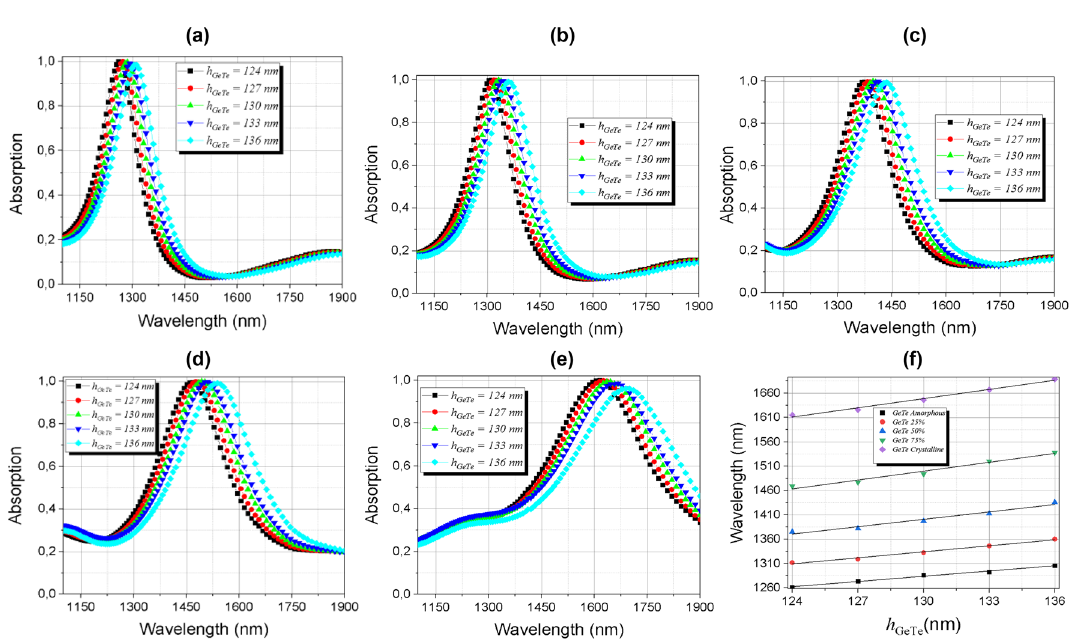
Figure 12. Absorption dependence of the PCM thickness h GeTe in the range of 1100–1900 nm ( a ) amorphous; ( b ) semi-crystalline (m = 25%); ( c ) semi-crystalline (m = 50%); ( d ) semi-crystalline (m = 75%); ( e ) crystalline phases and ( f ) linear dependence of the peaks of ( a – e ) with the thickness of the GeTe layer ( h GeTe